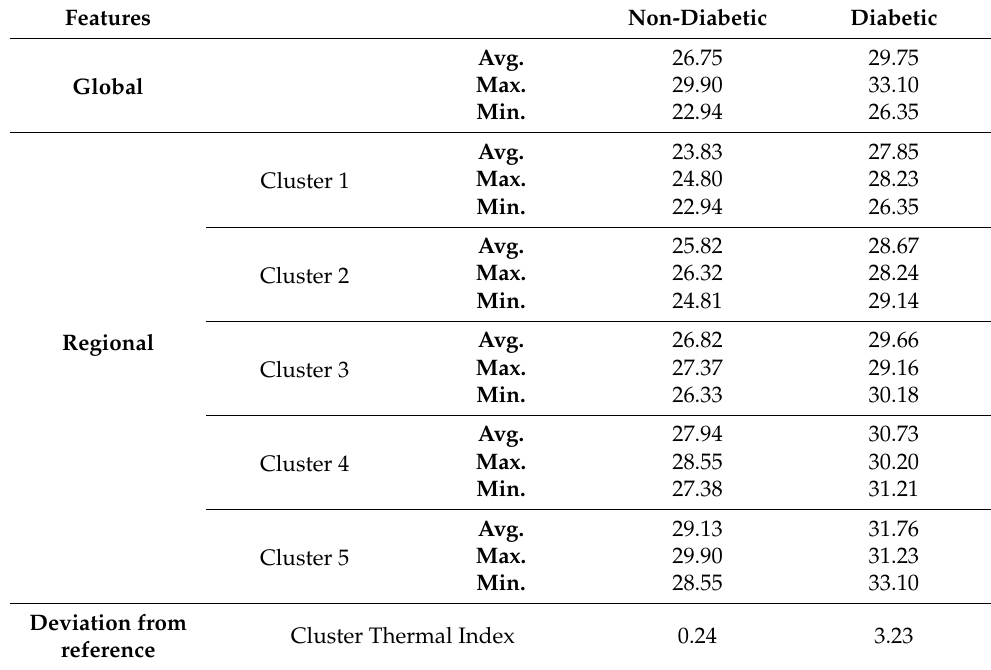
Table 2. Extraction of features in the thermograms of two subjects: Non-diabetic and